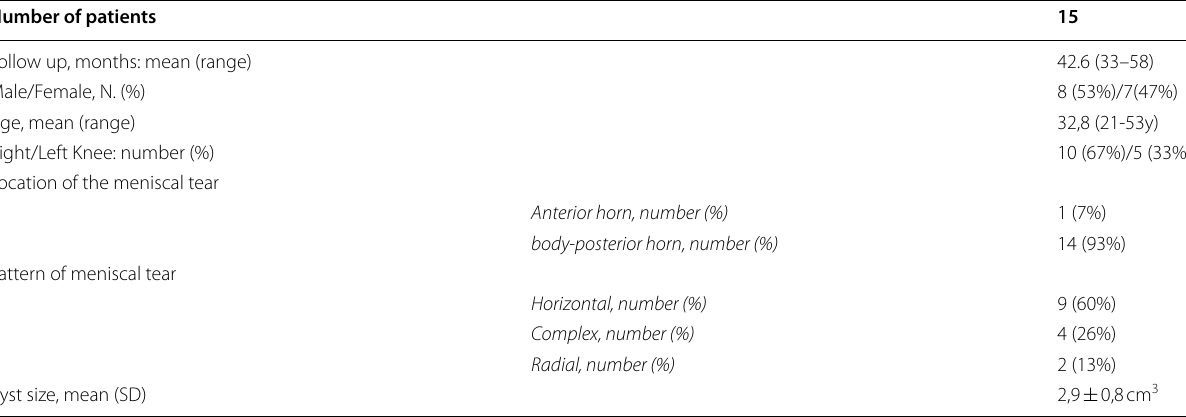
Table 2 characteristics of patients included in the study. SD: standard deviation Number of patients